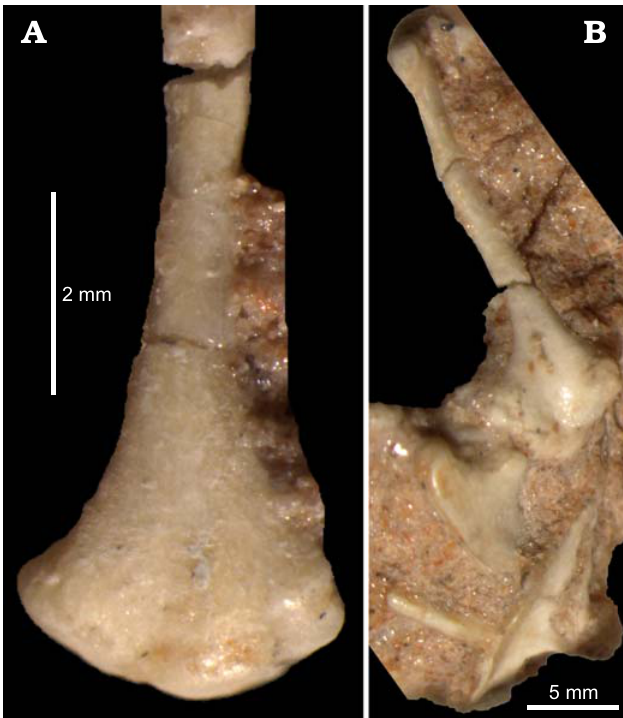
Fig. 5. Humerus of the stem-amphisbaenid Slavoia darevskii Sulimski, 1984 (ZPAL MgR-I/8) from late Campanian of Mongolia. A . Distal part in medial view. B . Humerus in ventral view, displaying also coracoid and interclavicule.